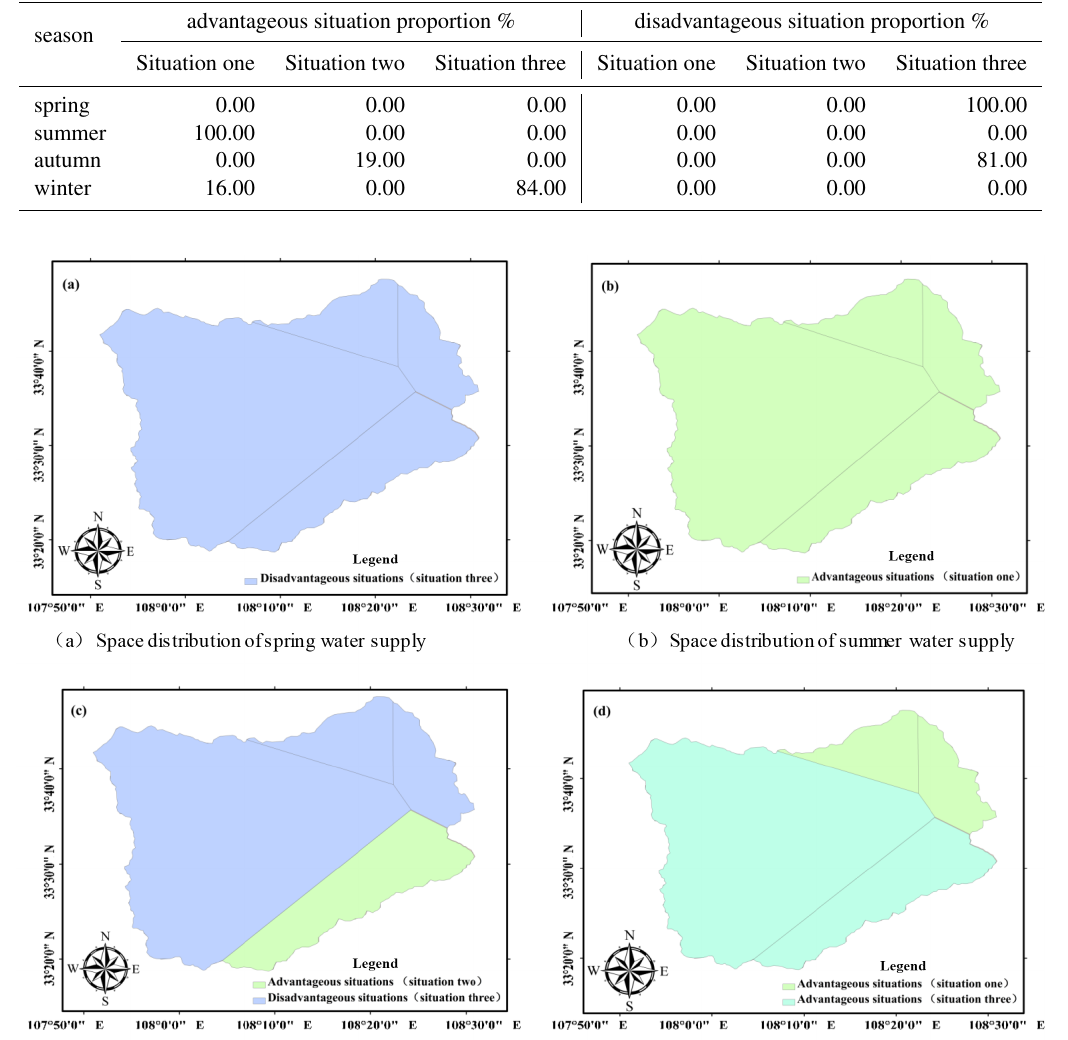
Table 6. Changes of future water supply characteristics of the basin.